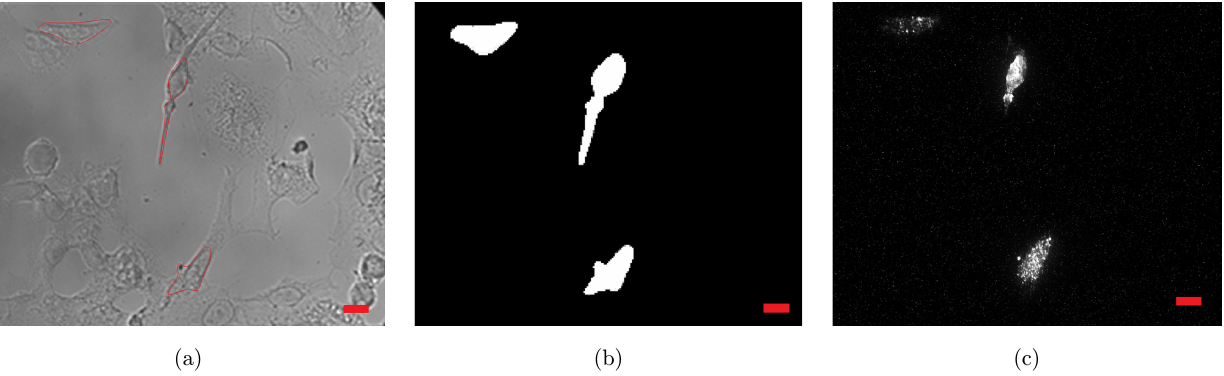
Fig. 6. The process of imaging dyed cells of interest. (a) the white light image of cells in the wide ¯eld mode in which the boundary of the samples of interest is marked by the red curve; (b) the required excitation light pattern matching the samples of interest and (c) the two-photon °uorescence image of dyed cells of interest. Scale bar is 10 (cid:1)